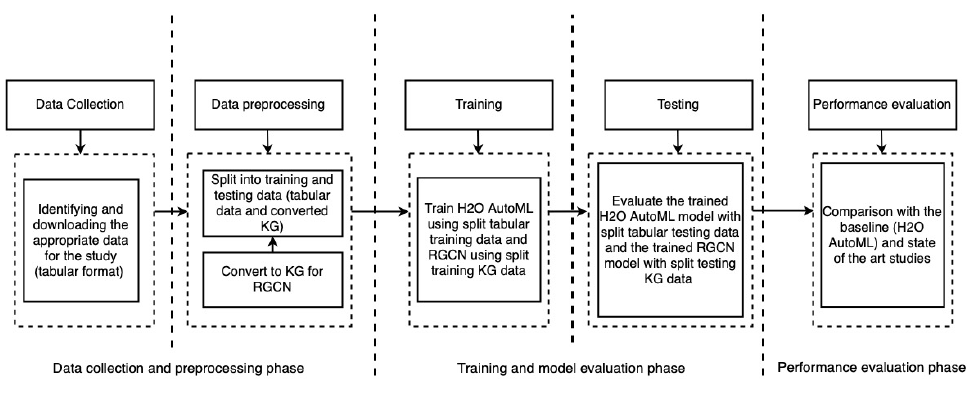
Figure 1. High level overview of followed